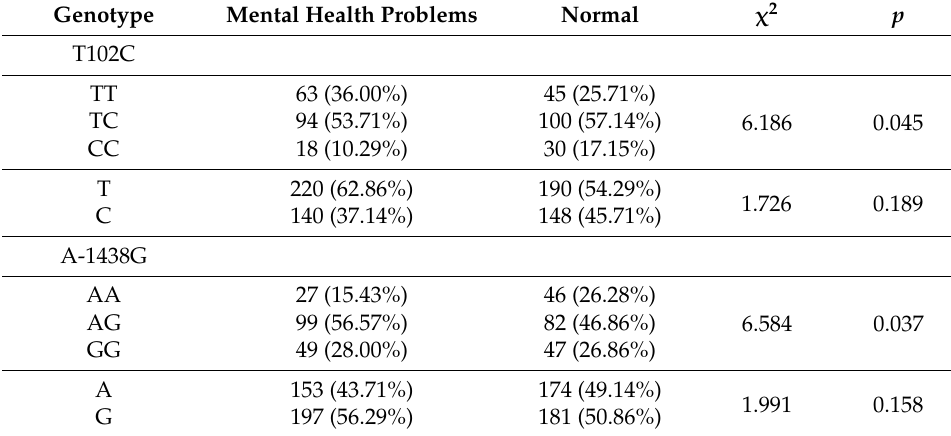
Table 5. The distribution of T102C, A-1438G genotypes and alleles n (%).